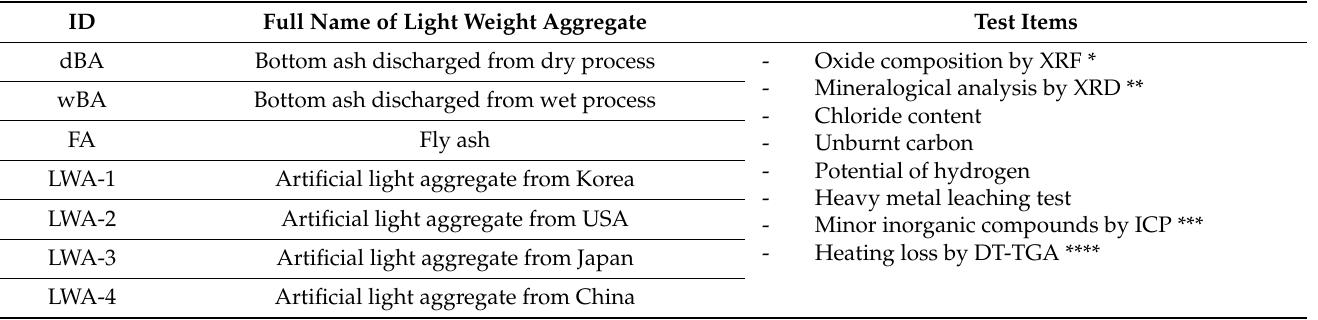
Table 3. Experimental